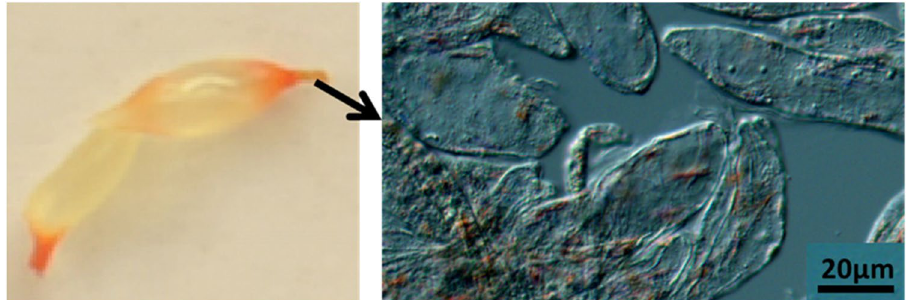
Figure 11. Occurrence of red crystalline chromoplasts in cells from CPTA treated Newhall flesh tissues. The juice vesicle was from flesh tissues separated from fruit at the S5 stage and then treated with CPTA for four weeks. CPTA, 2-(4-chlorophenylthio)-triethylamine